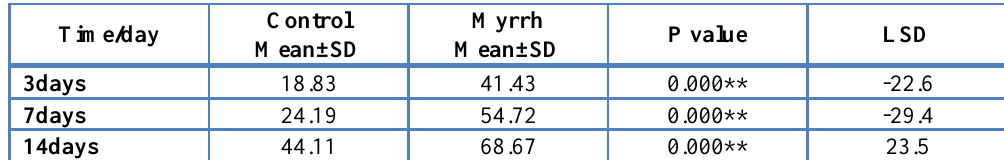
Table 4: Descriptive statistics of blood vessels account in each period interval